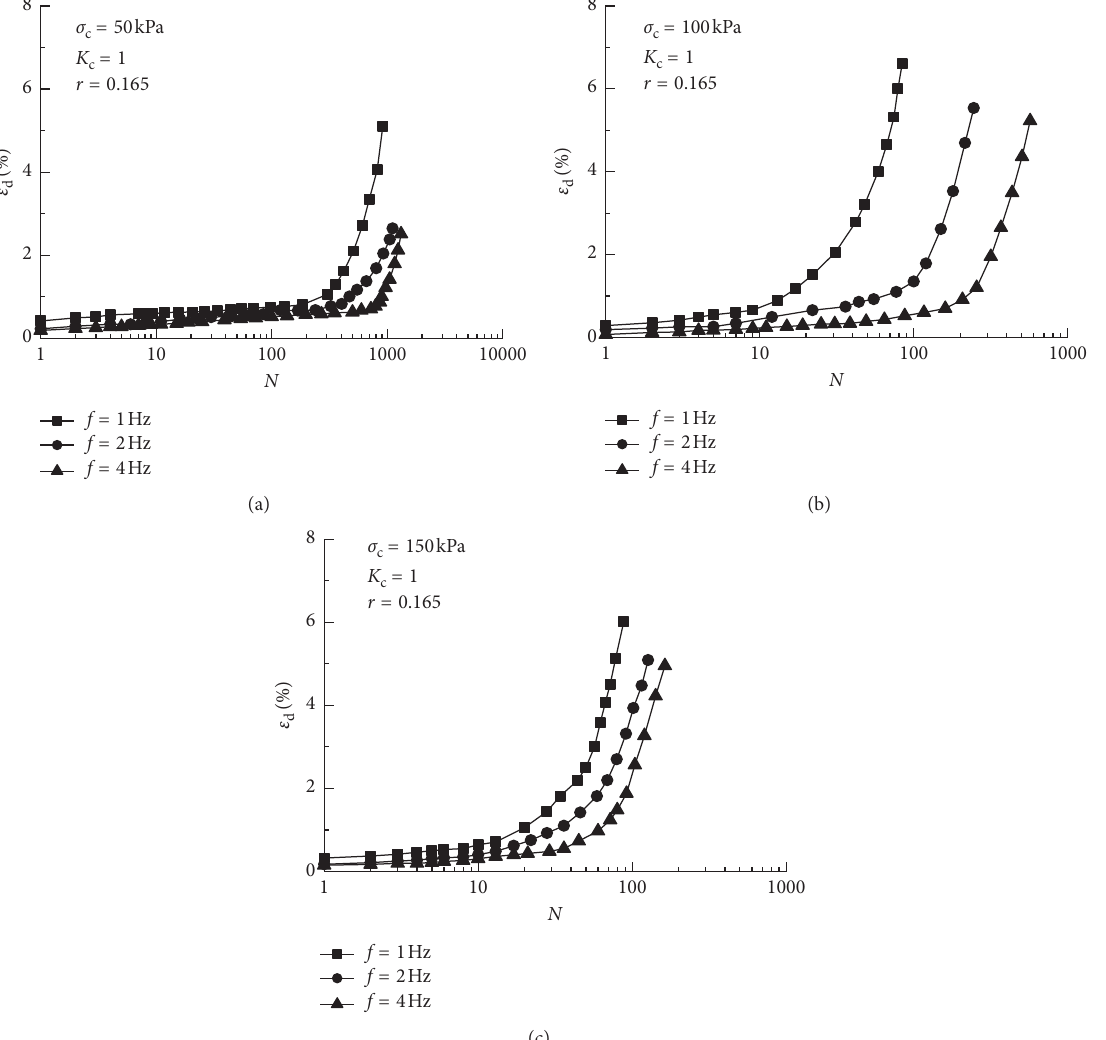
� 50kPa. (b) σ � 100 kPa. (c) σ � c c